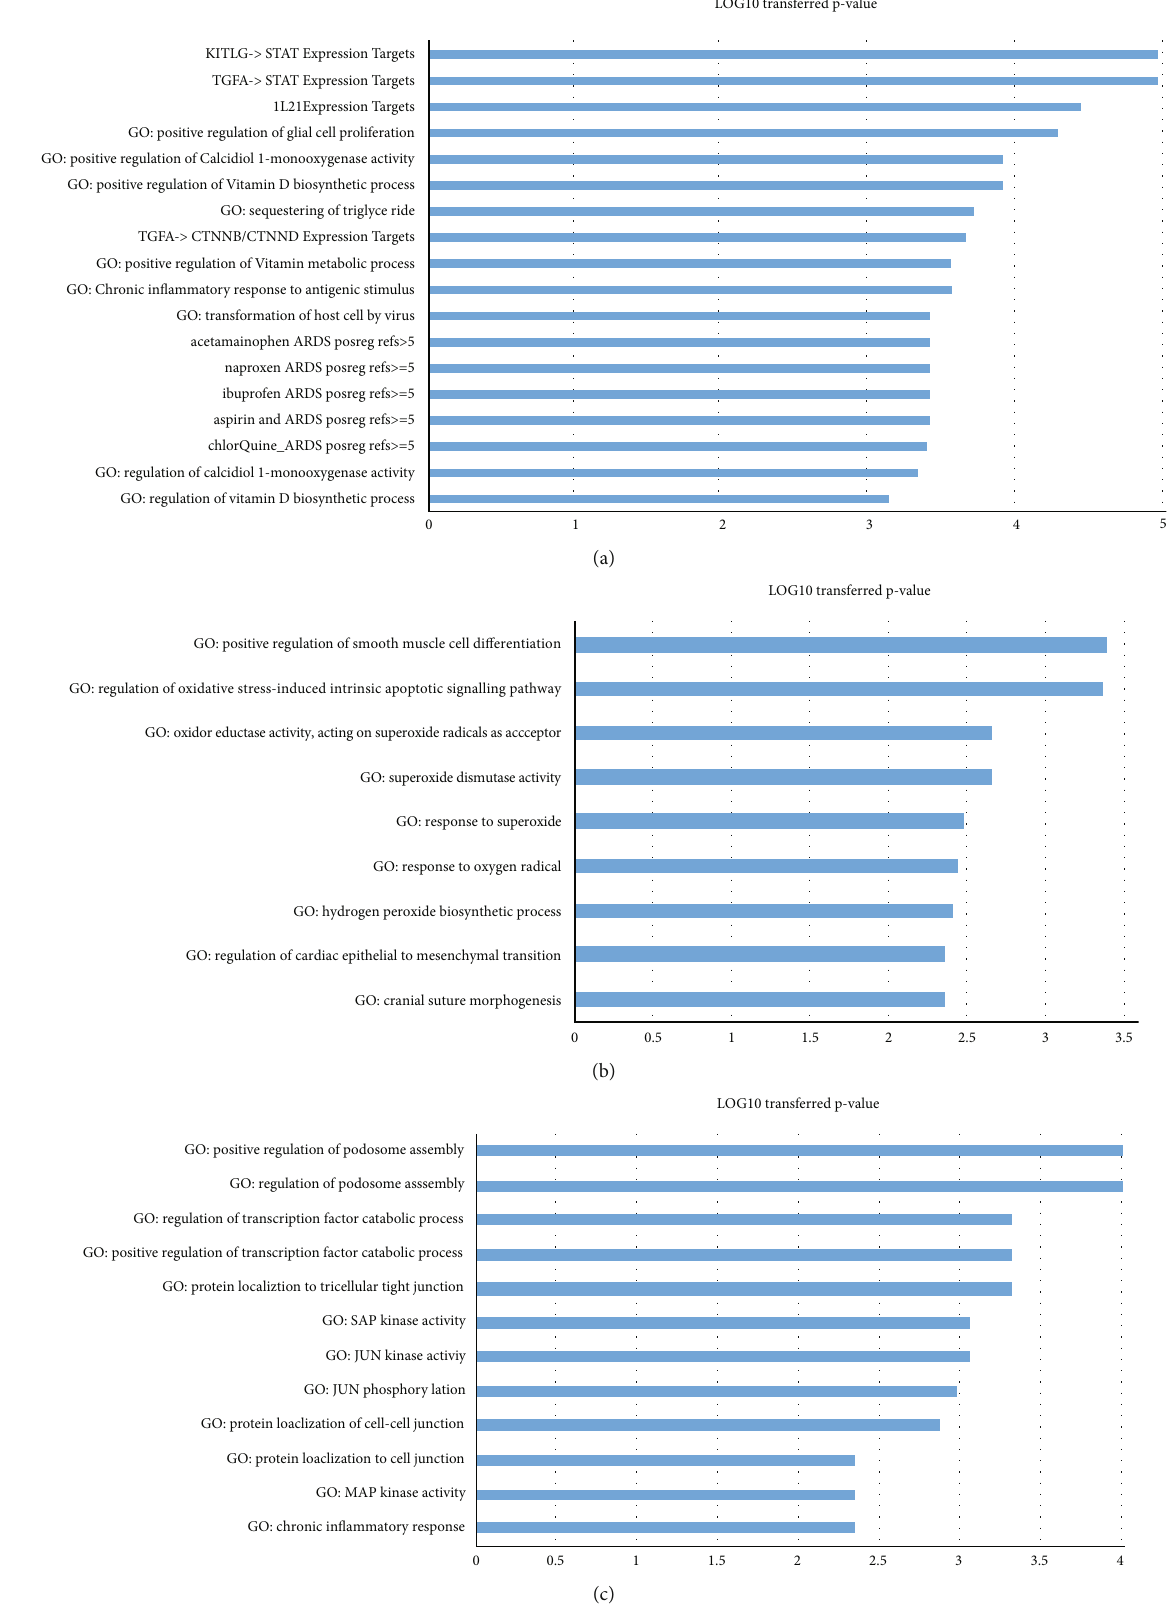
Figure 4: Pathway enriched analysis results: (a) the PEA results for eight PPARD-driven molecules to inhibit LA; (b) the PEA results for six PPARD-driven molecules to promote LA; (c) the PEA results for PPARD-driven LSCC regulators to inhibit